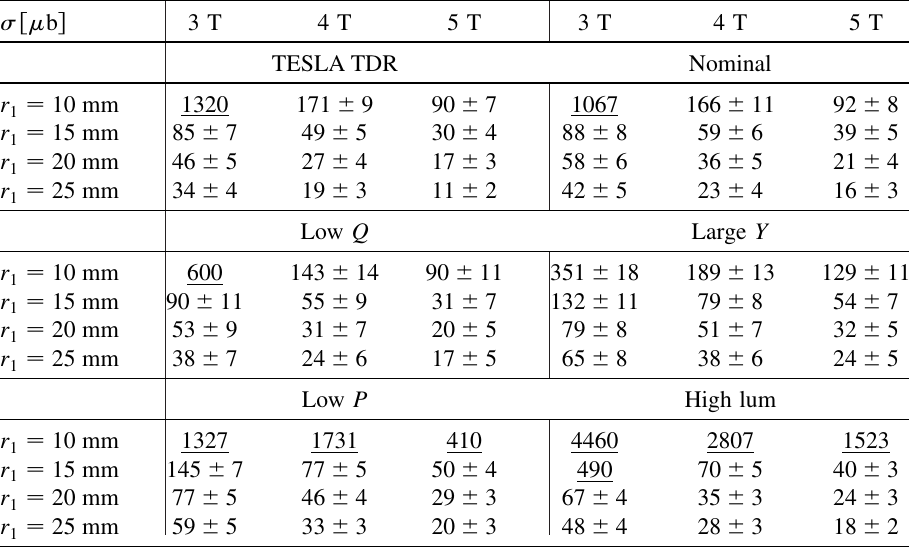
TABLE VI. Cross sections in (cid:6) b for the pair background reaching the VD per bunch crossing for different beam parameters sets. The TESLA TDR case is shown for